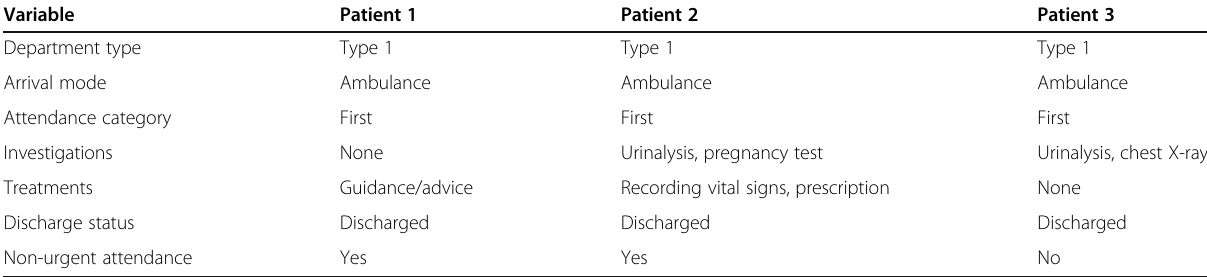
Table 1 Illustrative example of how the definition is applied to patients